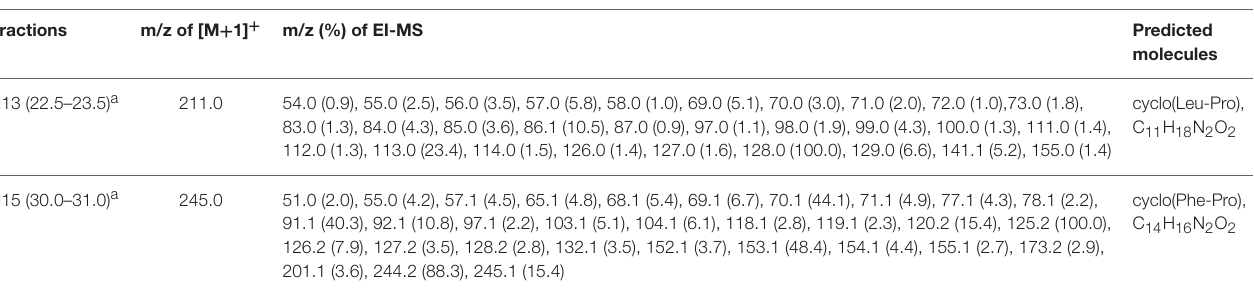
TABLE 3 | Mass analysis of Ln. mesenteroides LBP-K06 fractions by EI and CI using GC-MS. Fractions